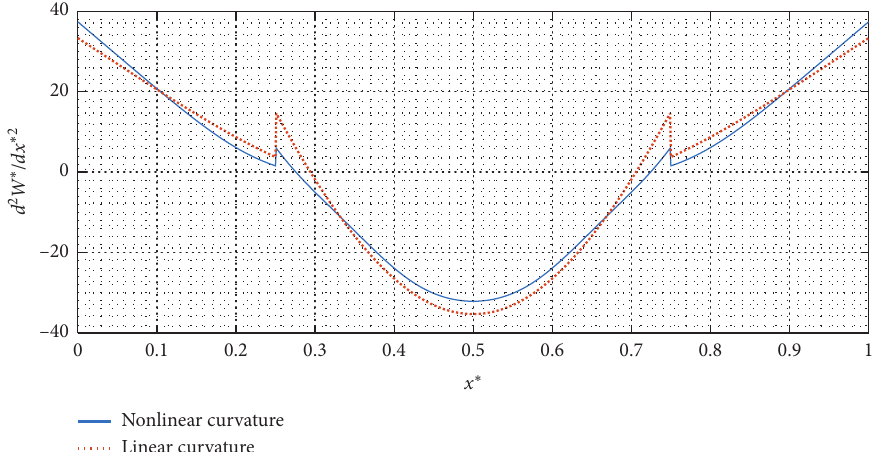
Figure 9: The curvature distribution of beam (c). Maximum nondimensional amplitudes ( W ∗